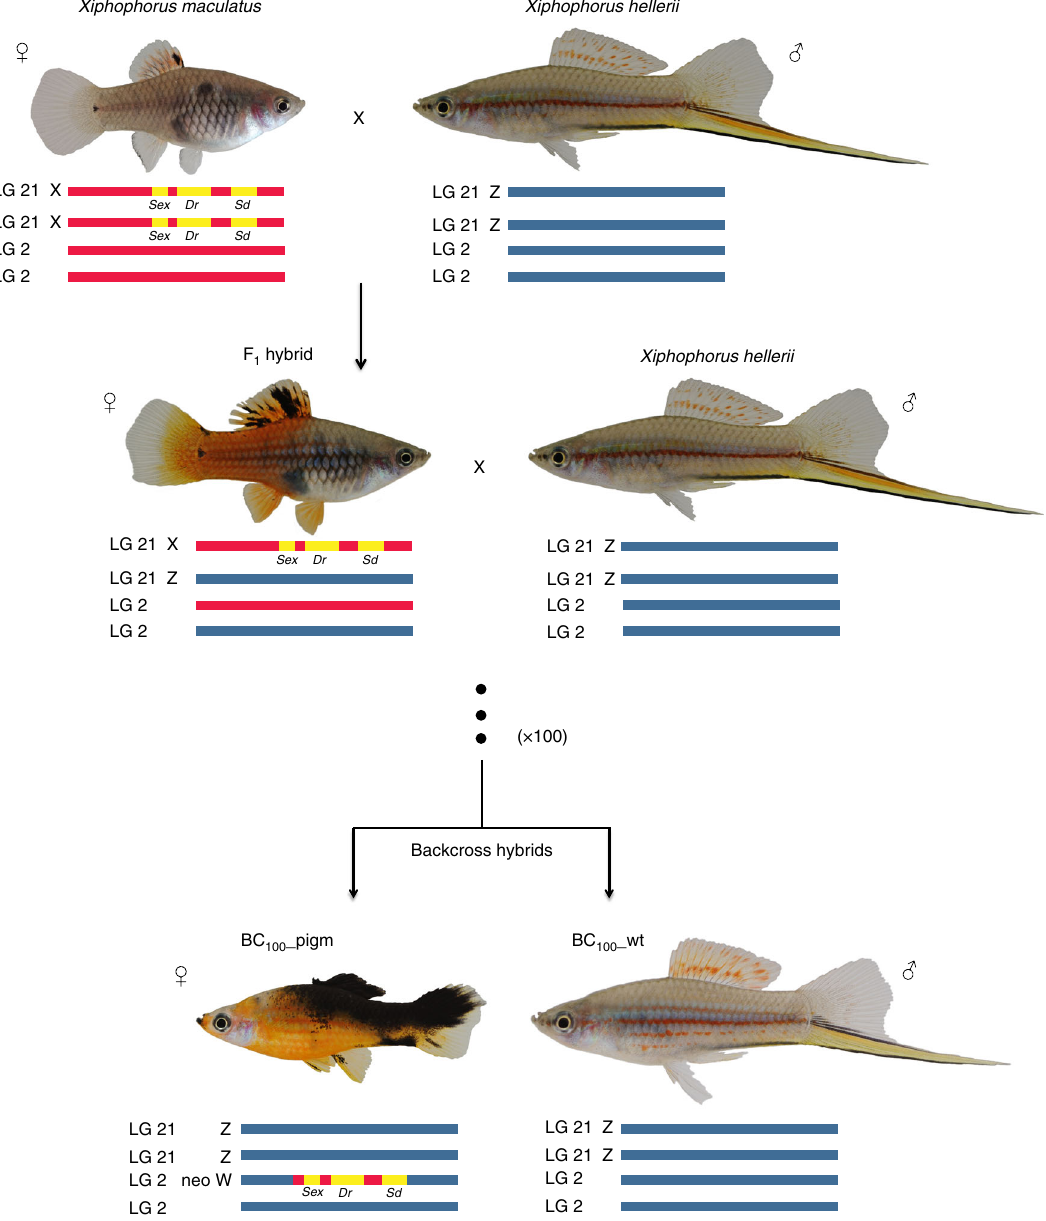
Fig. 1 Schematic outline of the laboratory cross. The parental species X. maculatus and X. hellerii , a female specimen of the fi rst generation hybrid and the resulting offspring obtained after approximately 100 generation of backcrosses (see Methods for details) are shown. The dorsal red ( Dr ), the spotted dorsal ( Sd ) and the oncogene xmrk loci, closely linked on the X-chromosome of the platy fi sh (LG21), are also highlighted. A translocation event of a genomic region containing these loci accompanied by recombination suppression has likely contributed to the formation of a new sex chromosome, a neo W chromosome (LG2), during the backcross experiment. Fish images by M.